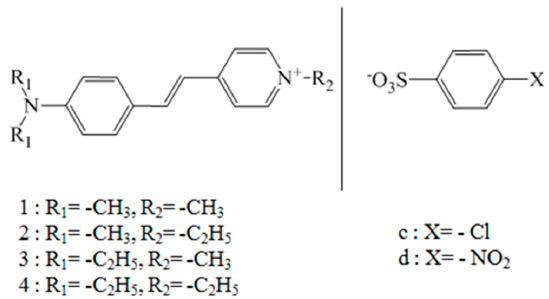
Figure 2. Molecule structures of ionic salts synthesized.